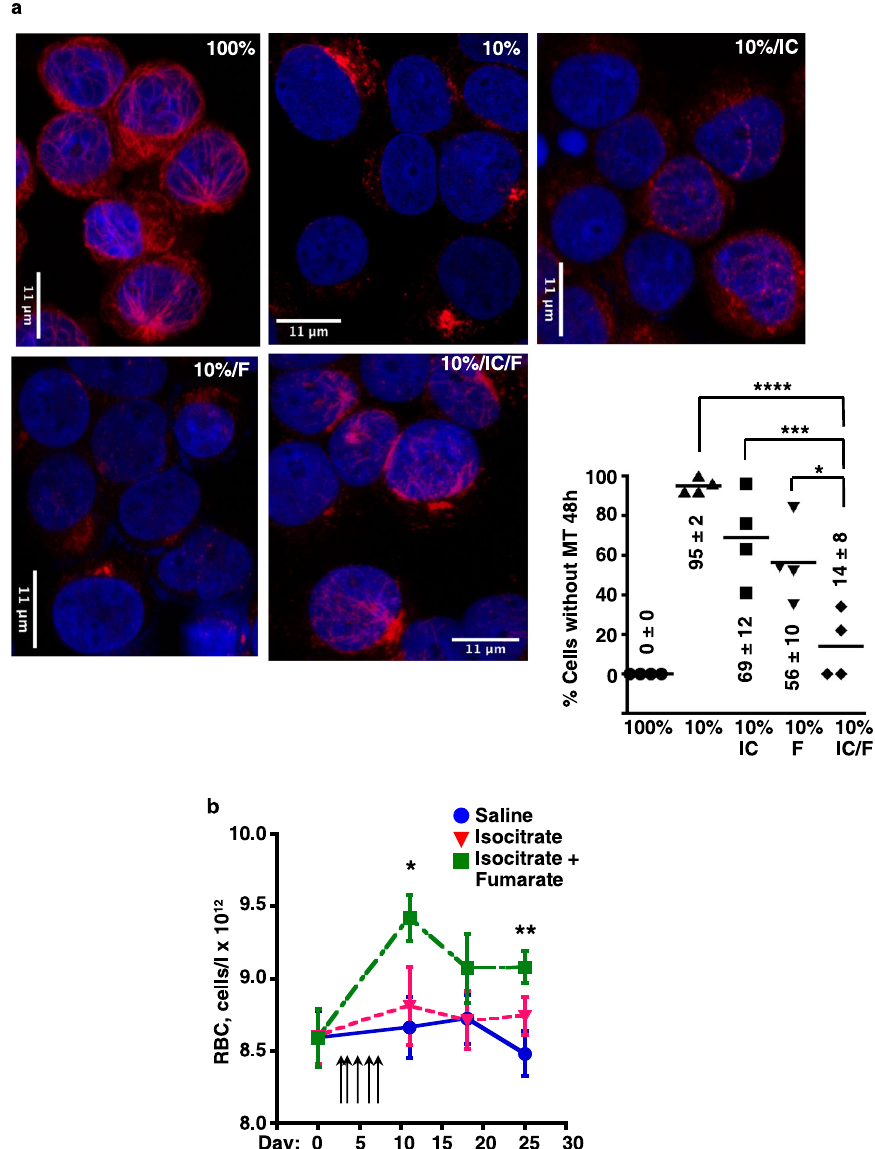
Fig. 6 Cooperative effects of isocitrate and fumarate on microtubules and on ACDI. a Microtubule restoration demonstrated by immuno fl uorescence on human CD34 + progenitors cultured 2 days in iron-replete (100% TSAT) or de fi cient (10% TSAT) erythroid medium ± 3 mM isocitrate (IC) and 1 mM fumarate (F). Red: β -tubulin; blue: DAPI. Graphs: % cells with undetectable microtubule structures (MT). Numbers indicate mean ± SEM; n = 3 biologically independent experiments; *, ***, **** P = 0.013, 0.0015, 0.0001, one-way ANOVA with Tukey post hoc test. b Amelioration of anemia in a murine genetic model of autoimmune arthritis. Mean red cell count (RBC) in 9-week-old KRN/G7 mice ± isocitrate (150 mg/kg/dose) and fumarate (18.6 mg/kg/dose) provided in fi ve daily intraperitoneal injections (arrows). Blue: saline treatment; red: isocitrate alone; green: isocitrate combined with fumarate Error bars, SEM; n = 9/group; *, ** P = 0.04, 0.008, one-way ANOVA with Dunnett correction using saline control as reference. Isocitrate alone had no signi fi cant effect. See also Supplementary Figs. 9 and 10. Source data are provided as a Source data fi